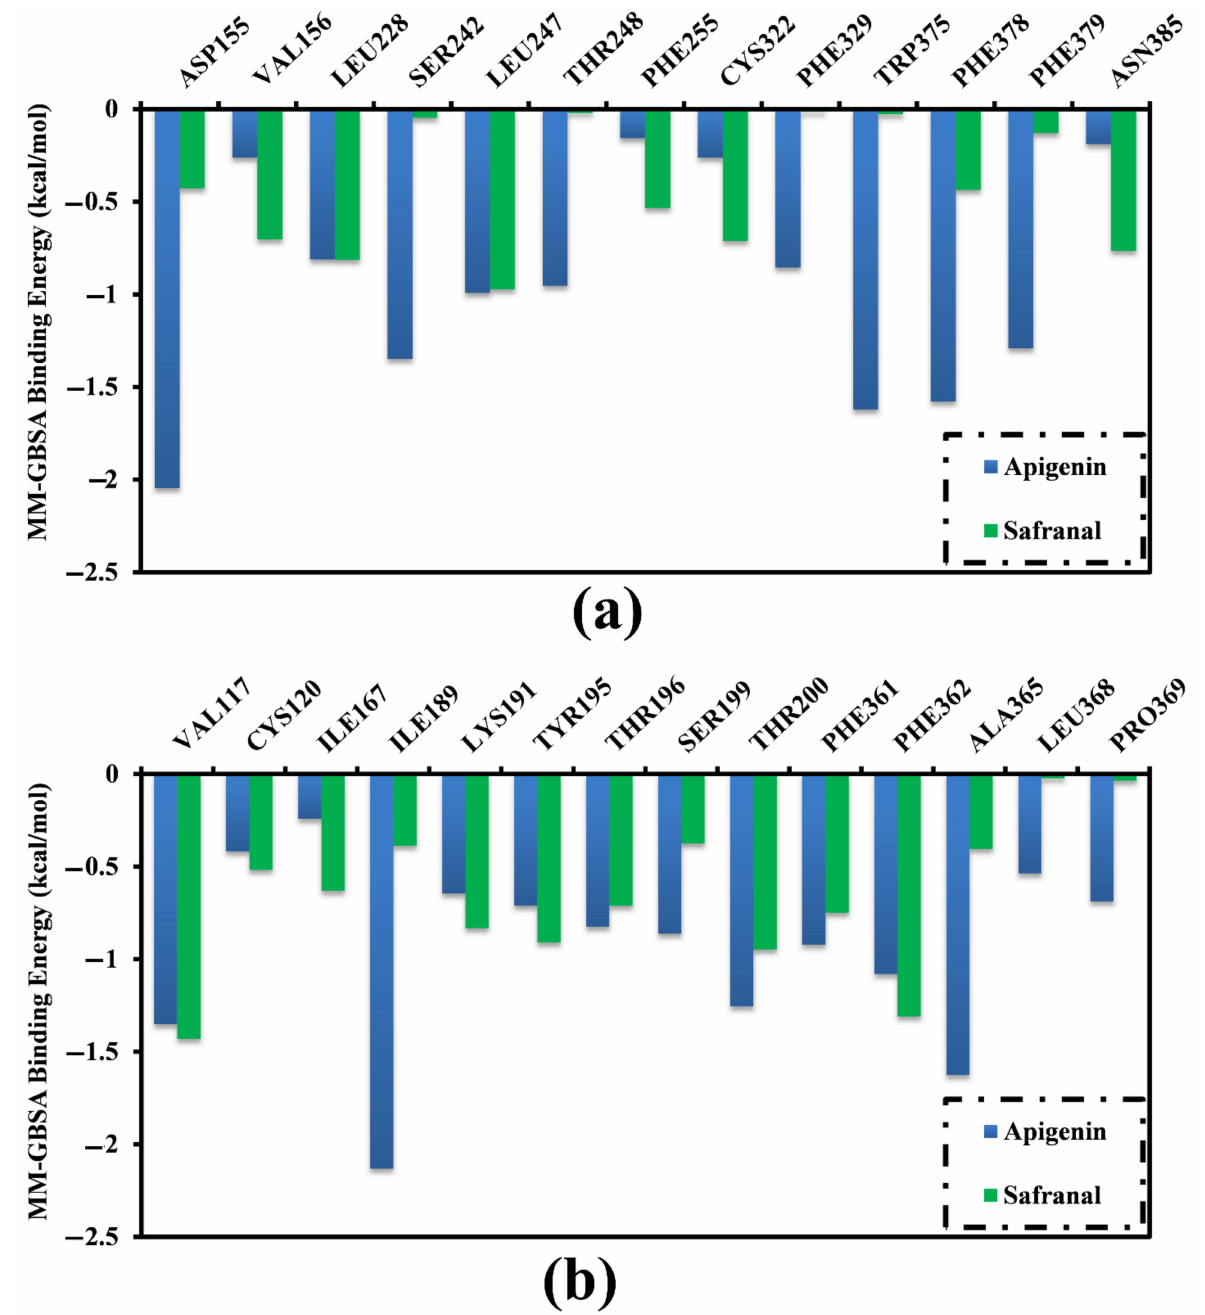
Figure 6. Per residue decomposition of the total binding affinity (kcal/mol) of apigenin and safranal complexed with ( a ) 5HT2AR and ( b )